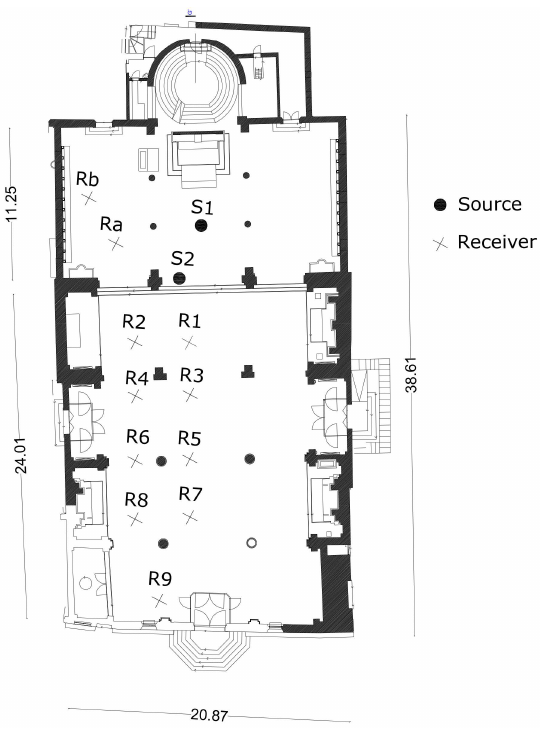
Figure 4. The map of the source and receiver